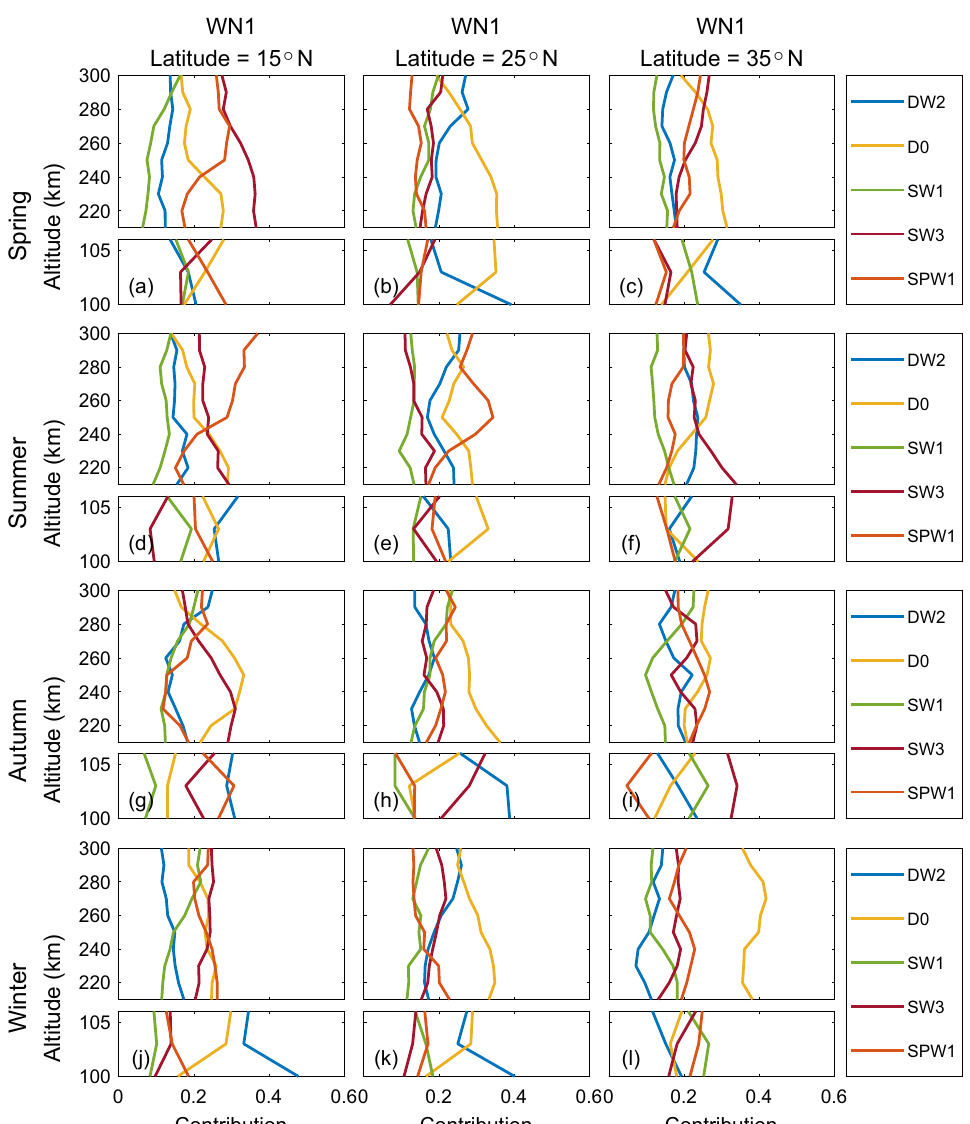
Fig. 4 The contribution of potential sources to WN1 in the altitude range of 100–106 km and 210–300 km in four seasons at three latitudes. Each subplot is divided into two panels, the top and bottom panels cover the altitude range of 210–300 km and 100–106 km, respectively. The blue, green, yellow, purple and orange line indicate the contribution of DW2, D0, SW1, SW3 and SPW1,